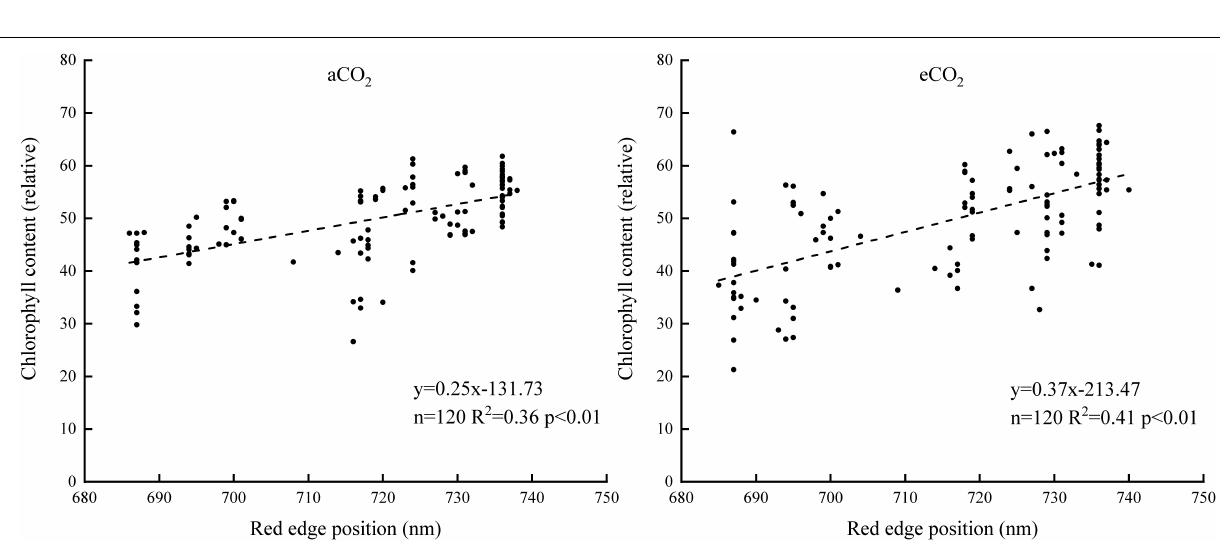
Frontiers in Plant Science |